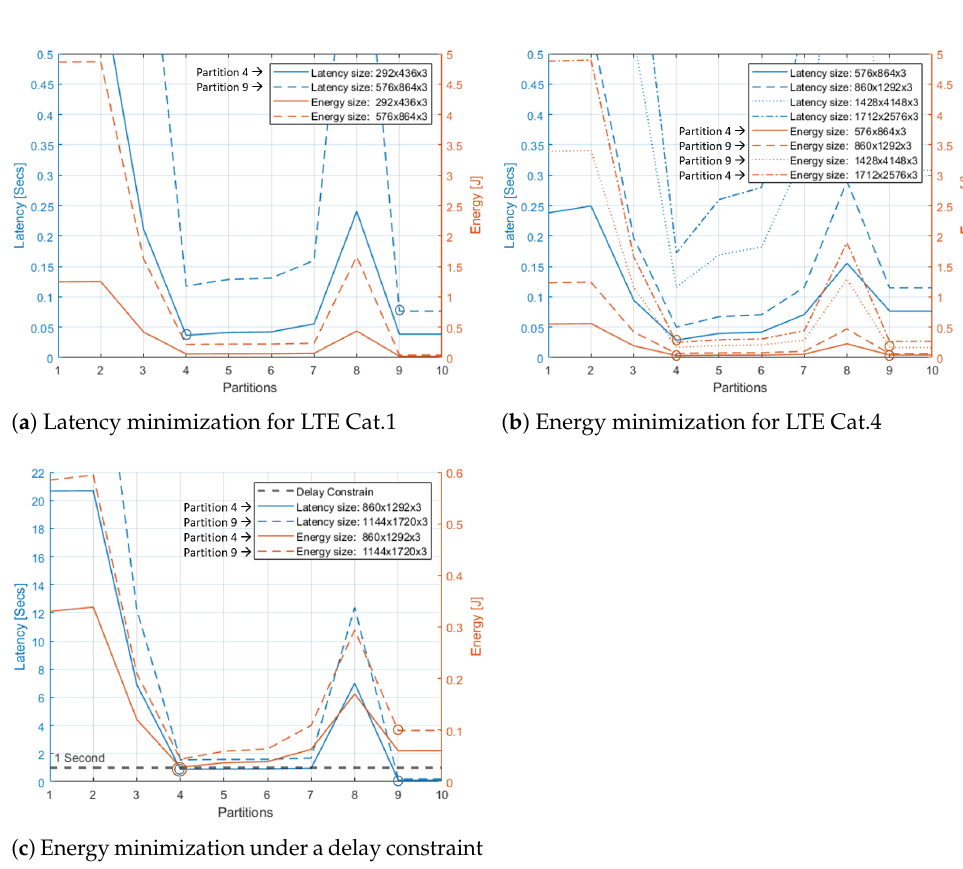
Figure 12. Latency and energy for three communication technologies and all possible partitions. The optimal partition points are marked with